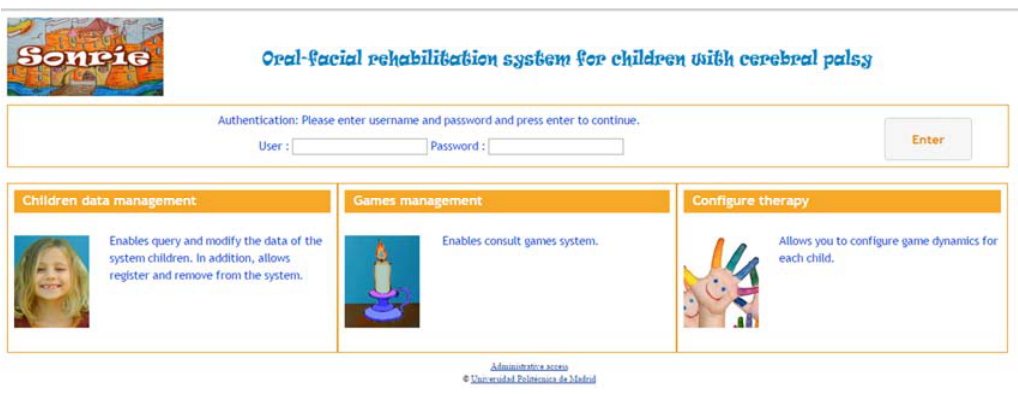
Figure 5. SONRIE Web based framework.